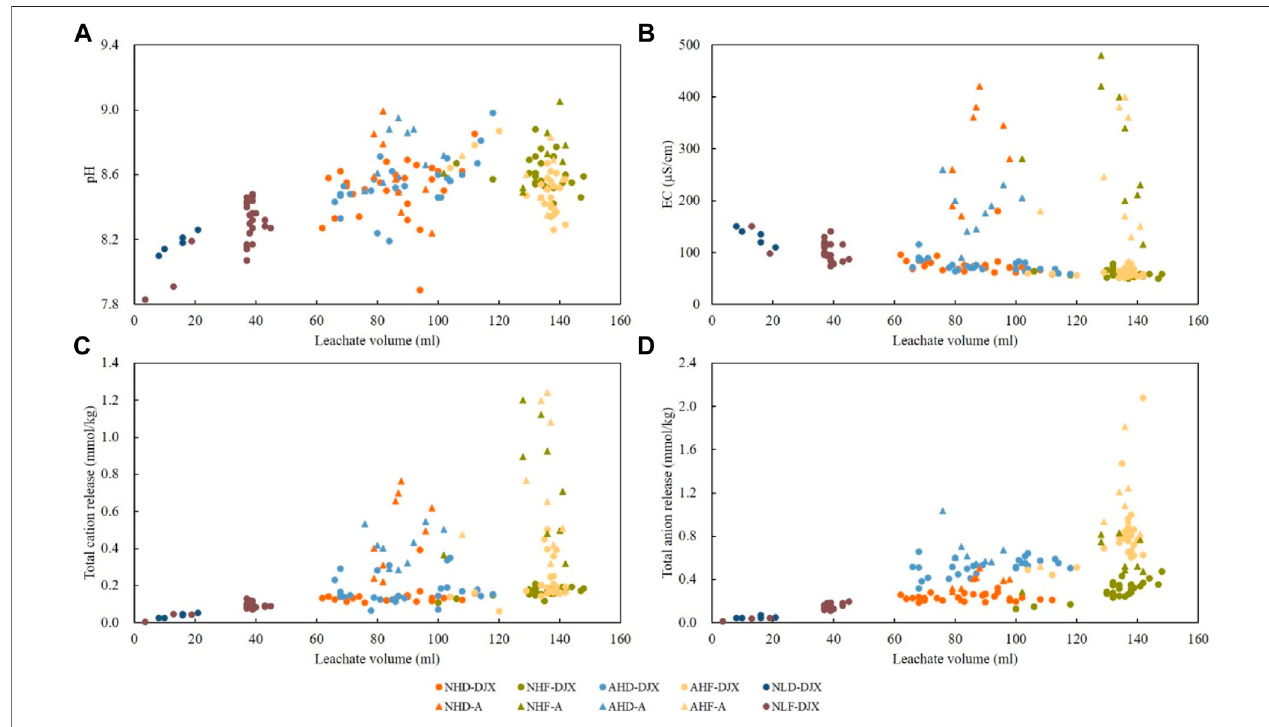
FIGURE9| Correlationbetween (A) leachatevolumeandpH, (B) volumeandelectricalconductivity, (C) volumeandtotalcationrelease,and (D) volumeandanion release. Codes of treatments are N — natural rain and A — acid rain; H — high intensity and L — low intensity; D — drying temperature and F — freezing temperature; D sample from Datang badlands, China; J sample from Jiangtian badlands, China; X sample from Xiahui badlands, China; A sample from Araguás badlands, Spain.